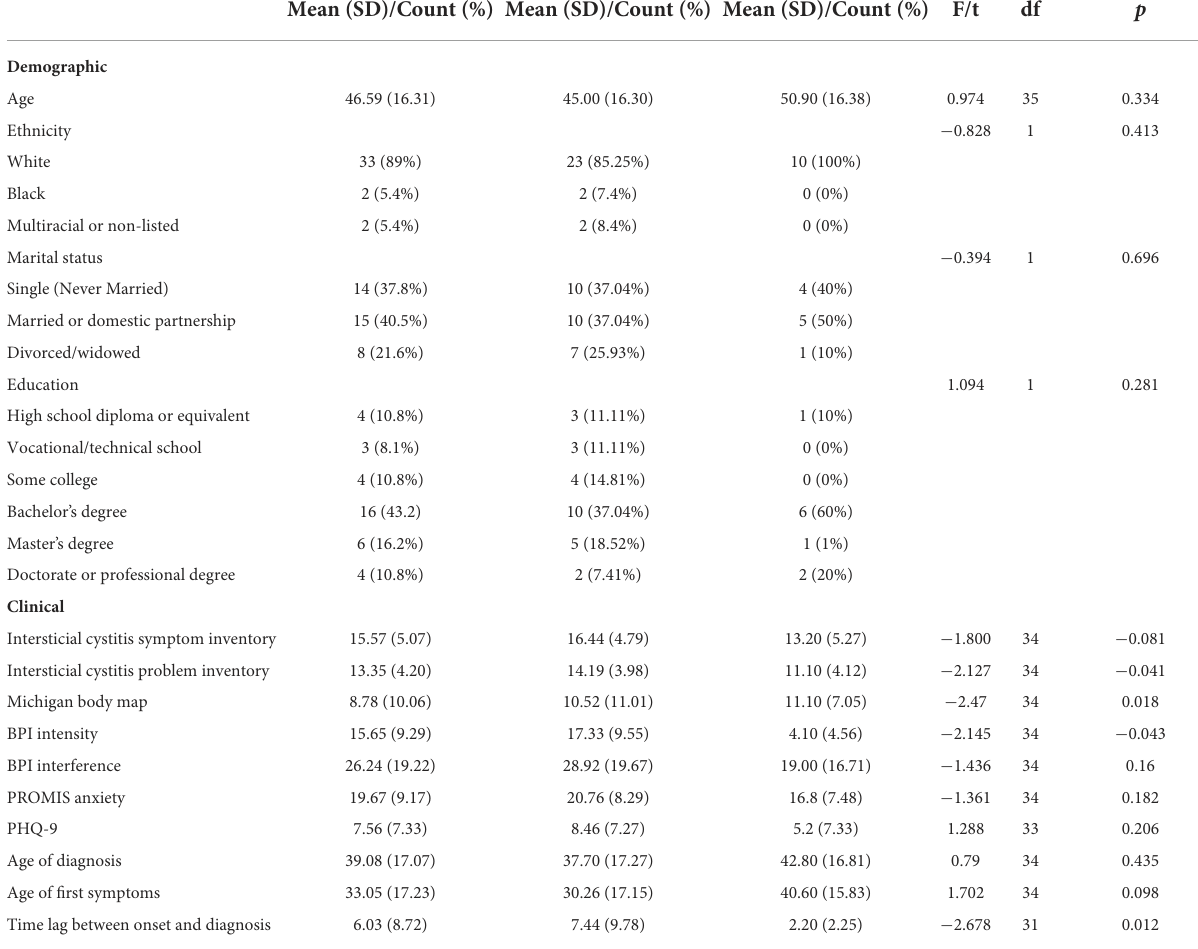
TABLE 1 Demographic and clinical characteristics of